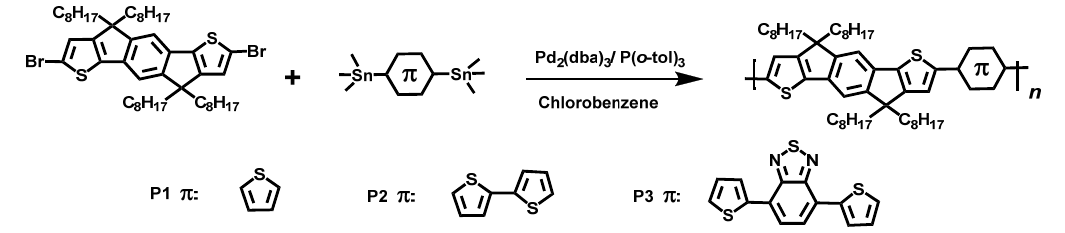
Figure 1. Chemical structures of the IDT unit and its copolymers.